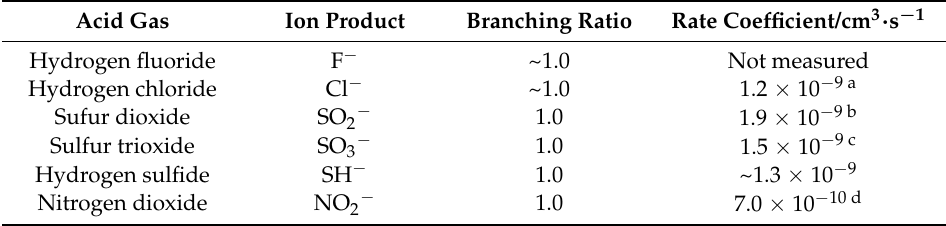
Table 6. O 2 − reactions of acid gases, nitrogen carrier gas, and flow tube at 120 ◦ C. Acid